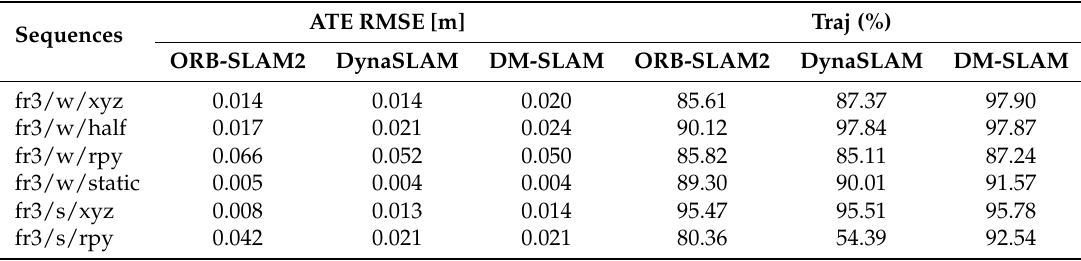
Table 2. Comparison of the RMSE of the ATE [m] and percentage of tracked trajectory for monocular